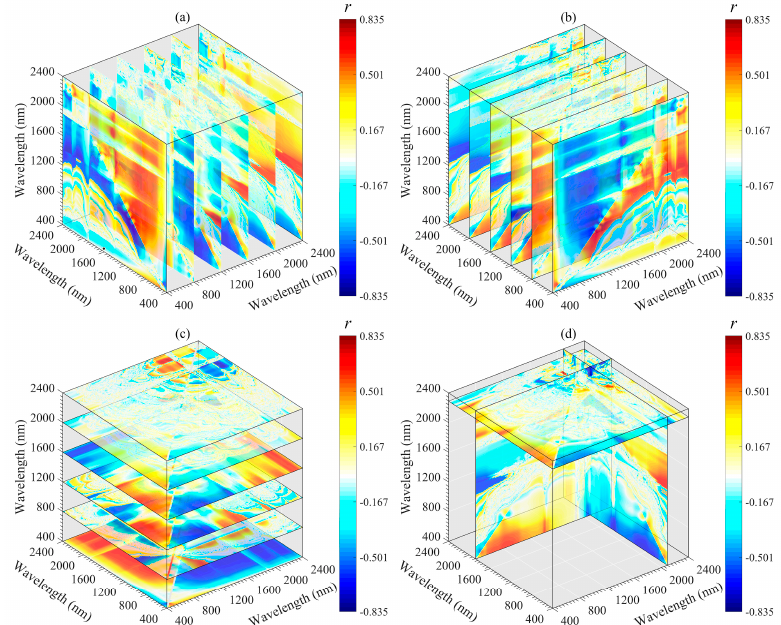
Figure 8. Three-dimensional slice maps of correlations between SOM content and TBI3 based on the calibration set ( n = 112). ( a – c ) represent slice maps based on the x -axis, y -axis, and z -axis, respectively, and ( d ) represents the optimal slice map.